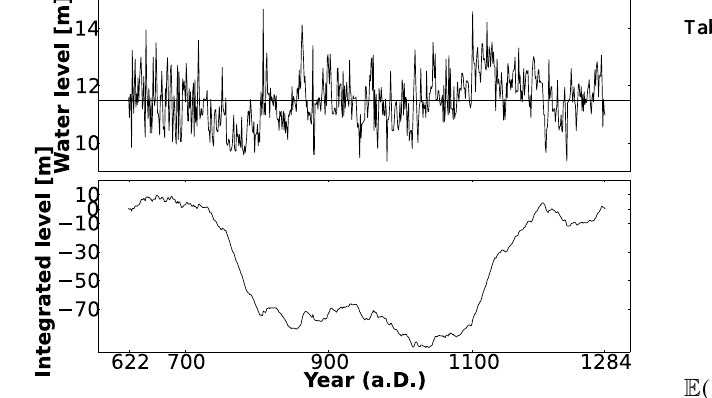
Fig. 7. (Top) The time series of minimal water levels of Nile River near Cairo. (Bottom) The integrated time series.